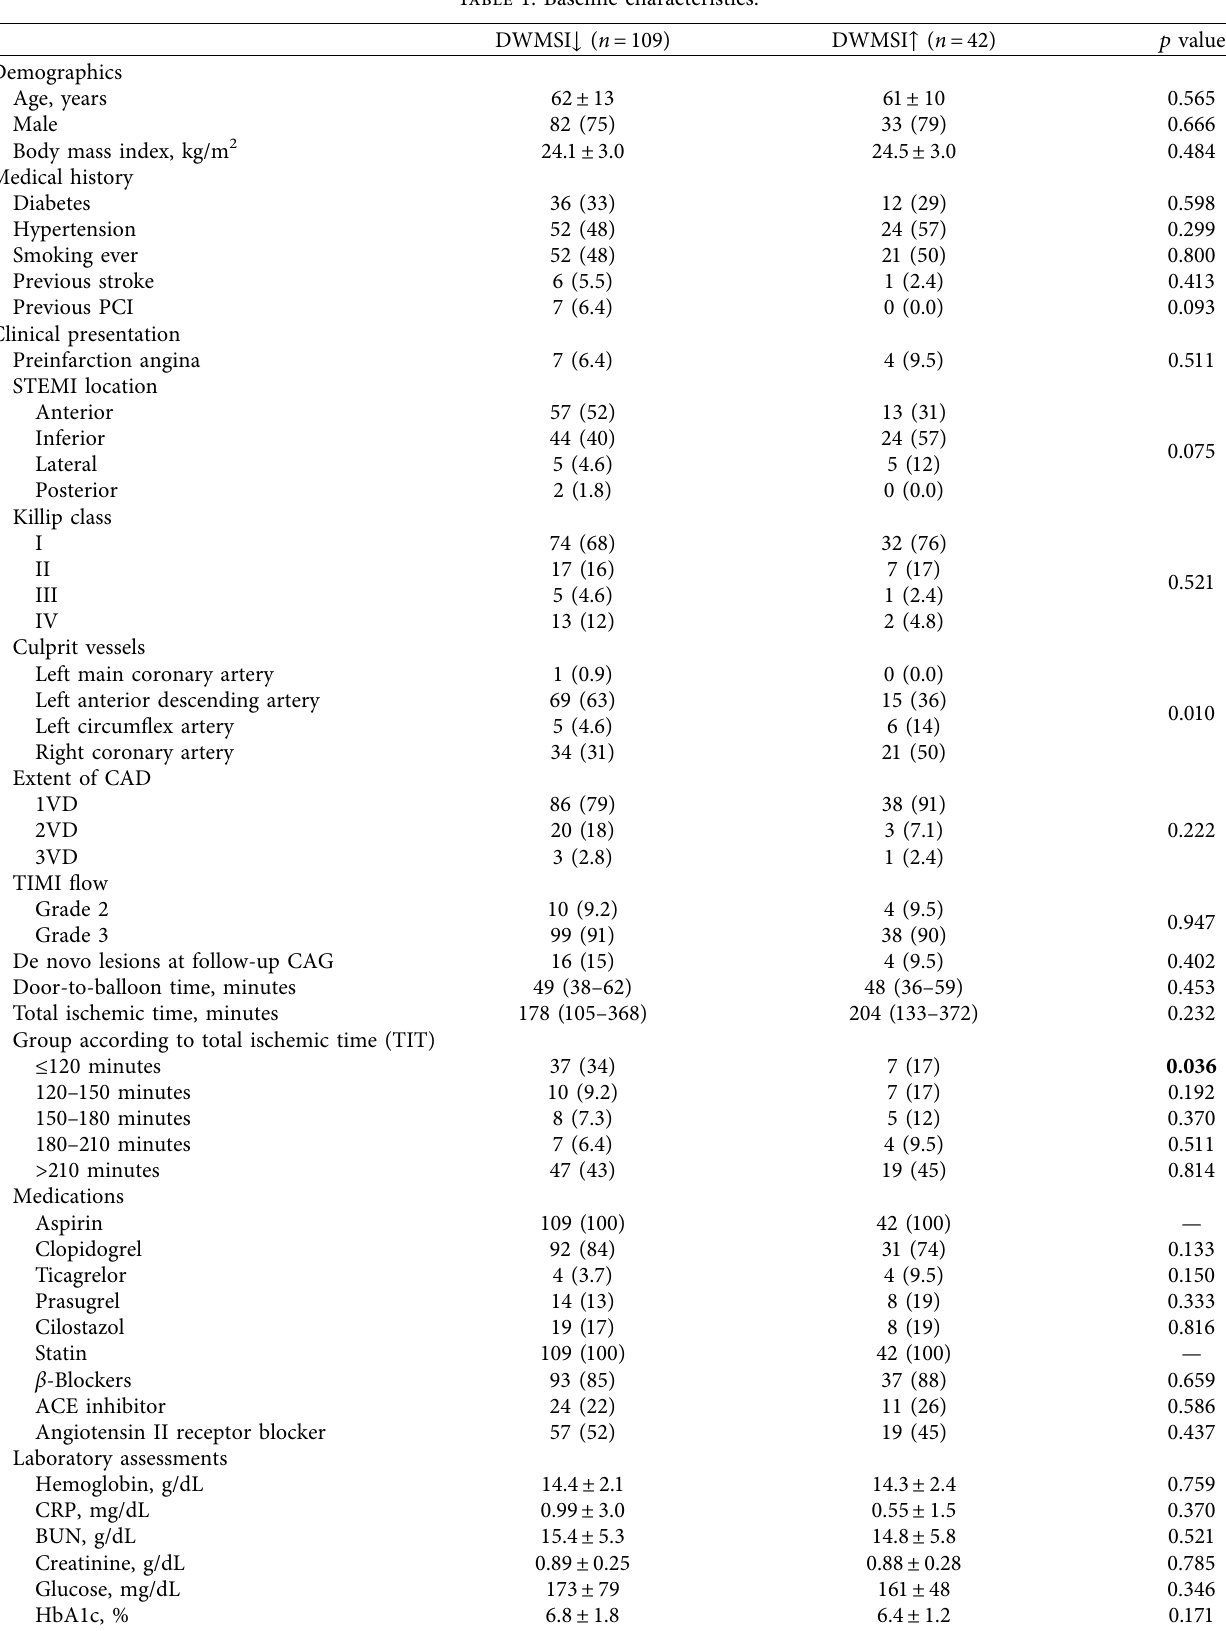
Table 1: Baseline